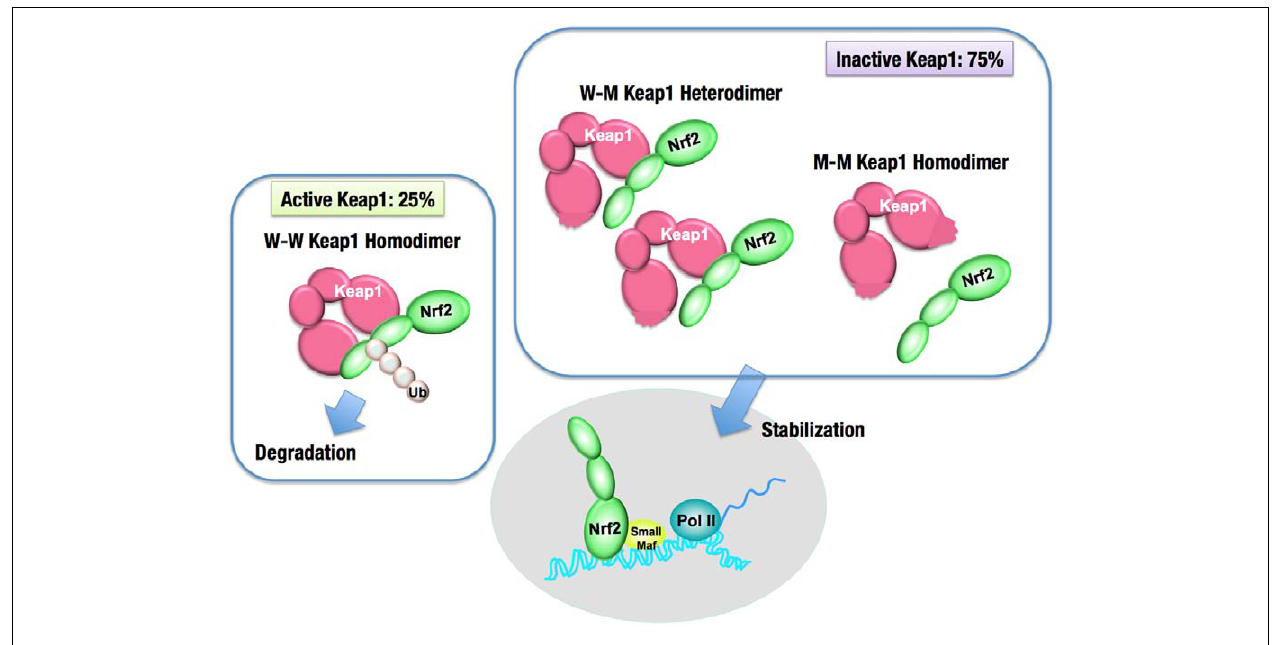
FIGURE 7 | Dominant negative effect of the Keap1 gene mutation. The intact Keap1 homodimer ubiquitinates Nrf2, while the Keap1 dimer, containing one or two mutant Keap1 proteins, cannot ubiquitinate Nrf2. A single allele mutation in the Keap1 gene results in the production of an equal